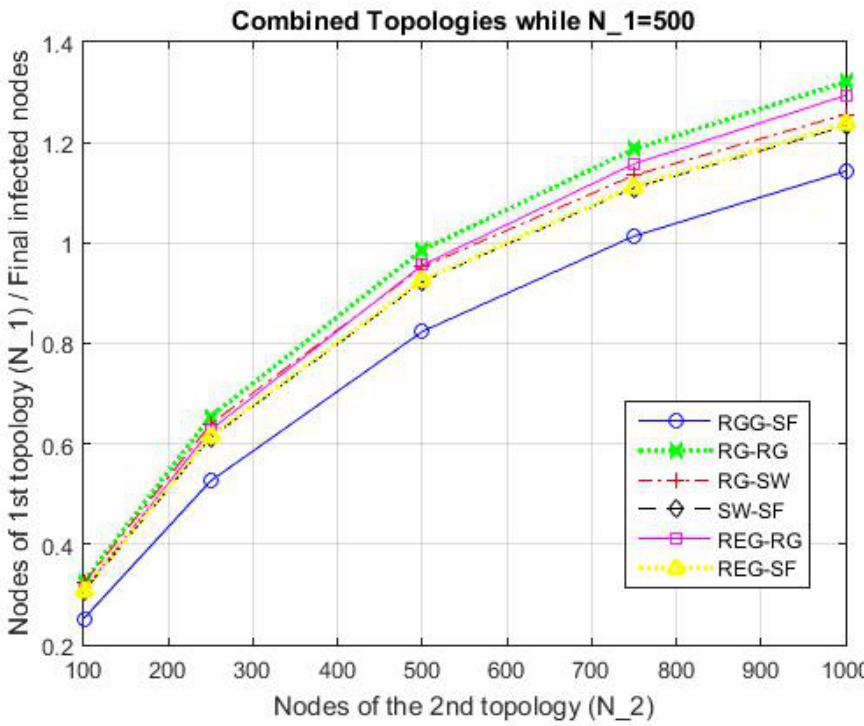
Figure 10. Spread of malware while the nodes of the 1st topology remain equal to N_1 =